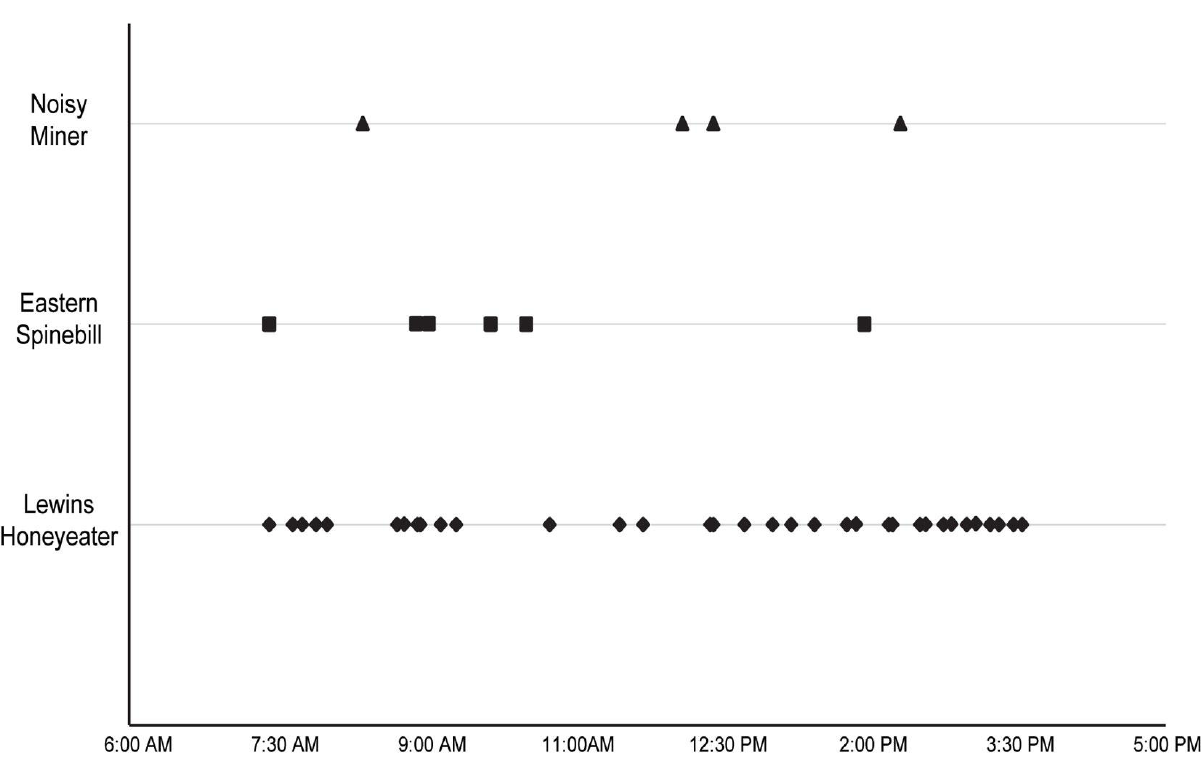
F IGURE 5. Visitation patterns of birds on Passiflora herbertiana. Floral visits generally began by 7:30 and stopped by 15:30 each day. Lewin’s Honeyeaters were most frequent with visits documented fairly consistently throughout the day. Eastern Spinebills were the next most frequent, followed by Noisy